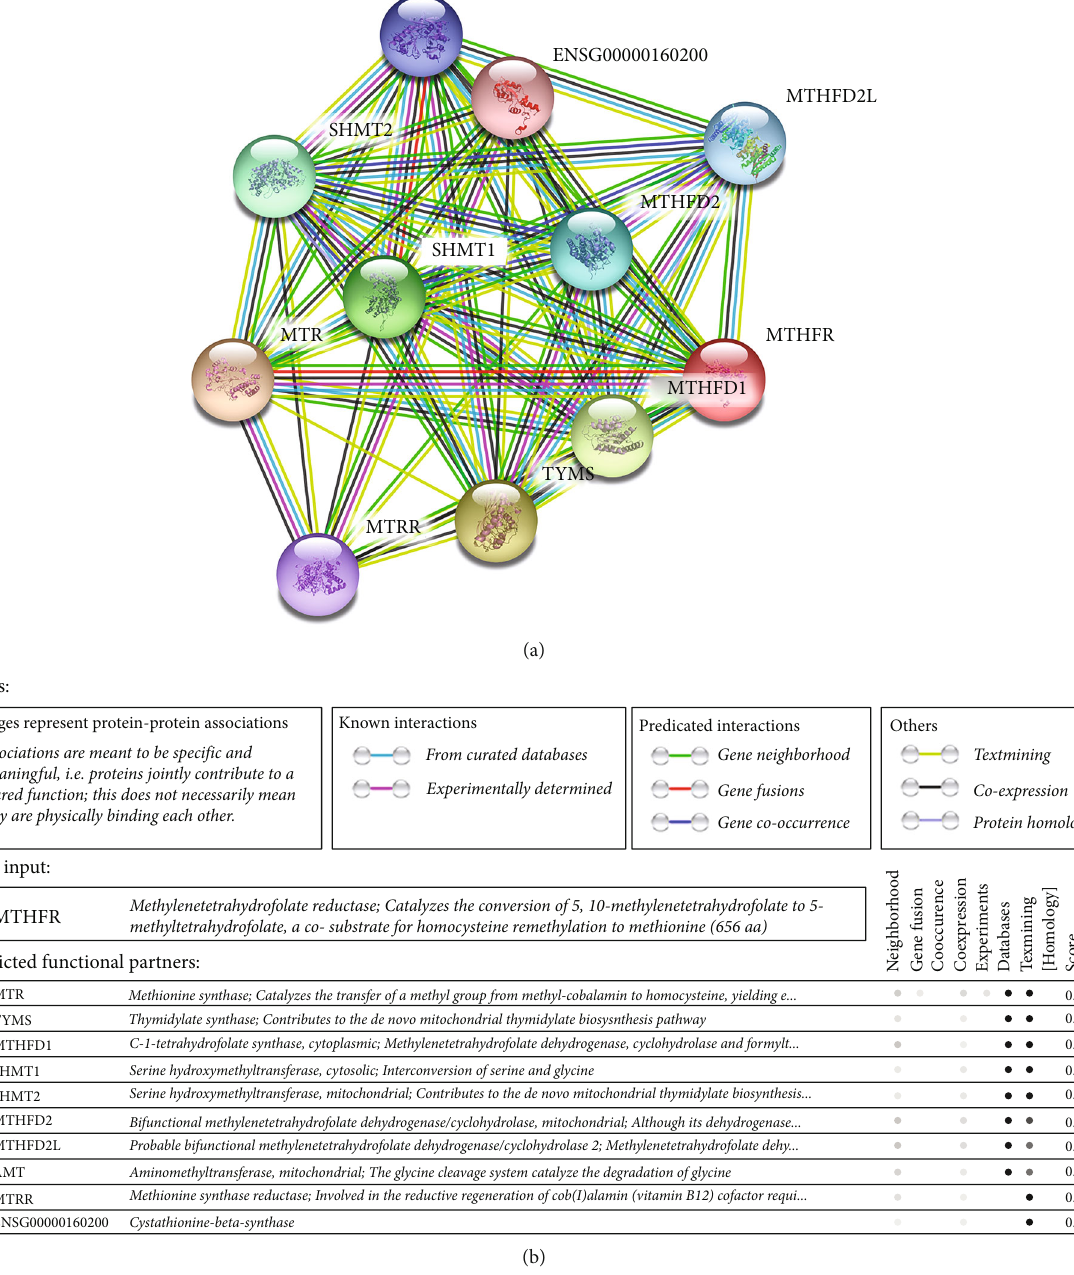
Figure 11: Human MTHFR interaction network with other genes obtained from STRING server. At least 10 genes have been indicated to correlate with MTHFR gene. (a) The gene-gene interaction. (b) The detail of relative ten core